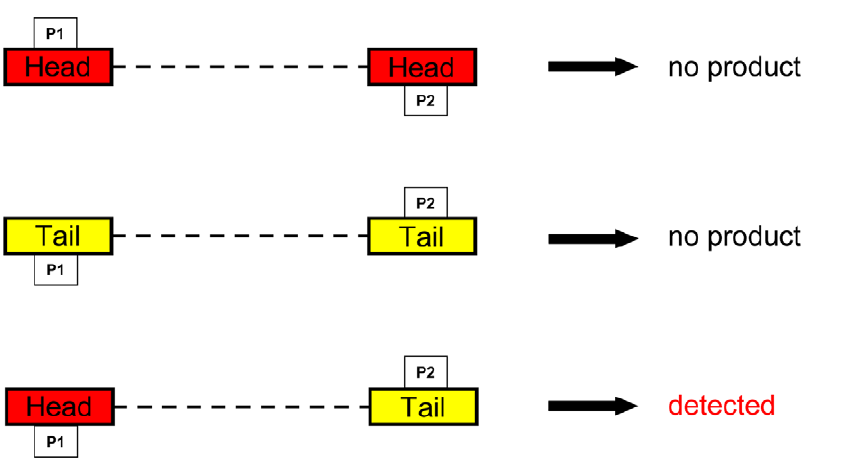
Figure 2. Theoretical structure of concatemeric sequences that could occur during HBoV replication. The boxes indicate the primers that were used for the amplification of the putative concatemeric structures. The broken lines indicate the linking sequence that is dependent on the length of the unknown terminal sequences.